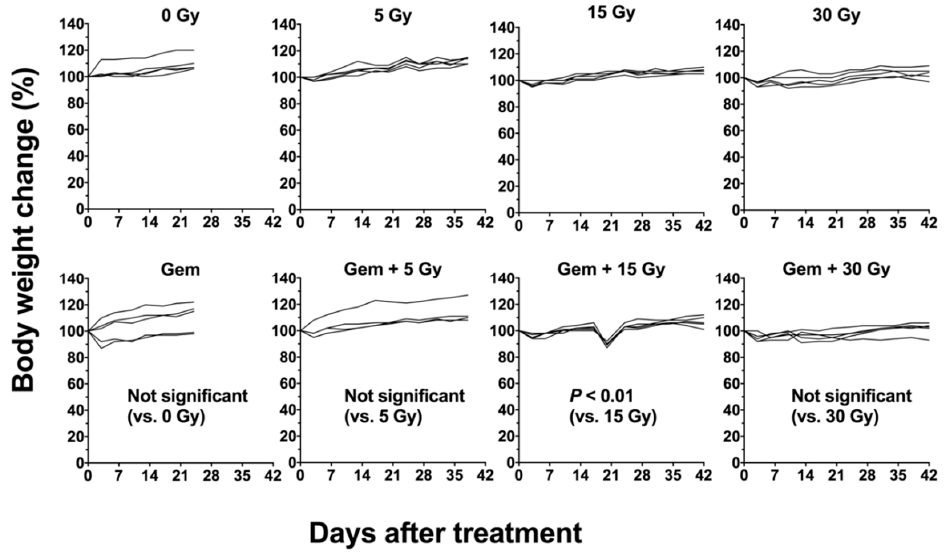
Figure 10. Individual body weight curves of mice bearing BxPC-3 tumors treated with X-ray radiation with or without gemcitabine (gem). 0 Gy, gem (240 mg/kg body weight) alone, 5 Gy, gem plus 5 Gy, 15 Gy, gem plus 15 Gy, 30 Gy, and gem plus 30 Gy. Body weight was measured at least twice a week.